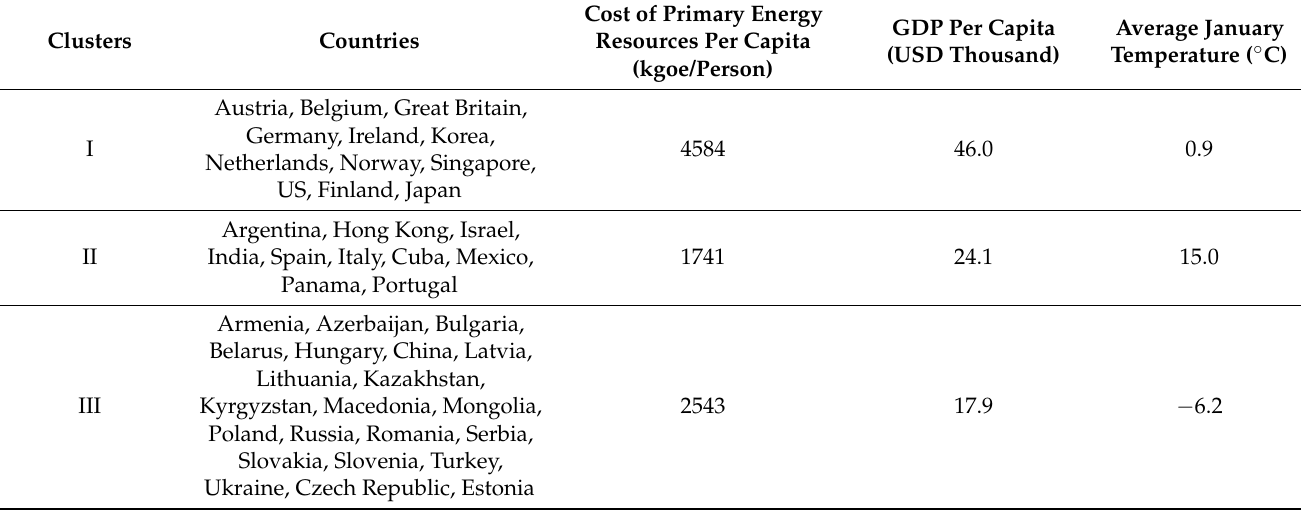
Table 1. Economic and energy indicators by clusters of countries